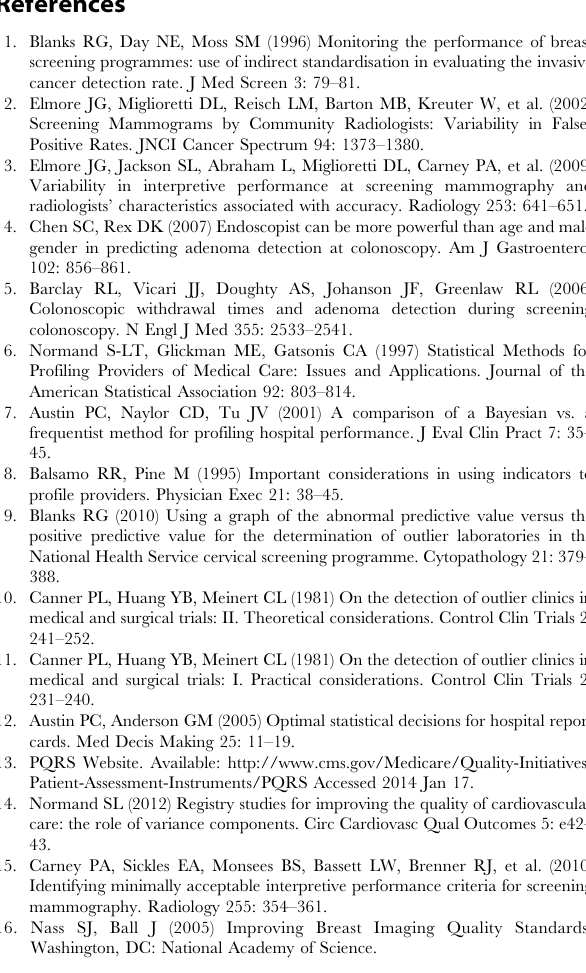
cancers detected must reflect whole numbers. The continuity correction becomes negligible for N . 3000 screening mammograms. Curves derived using the Poisson distribution illustrating the effect of the continuity